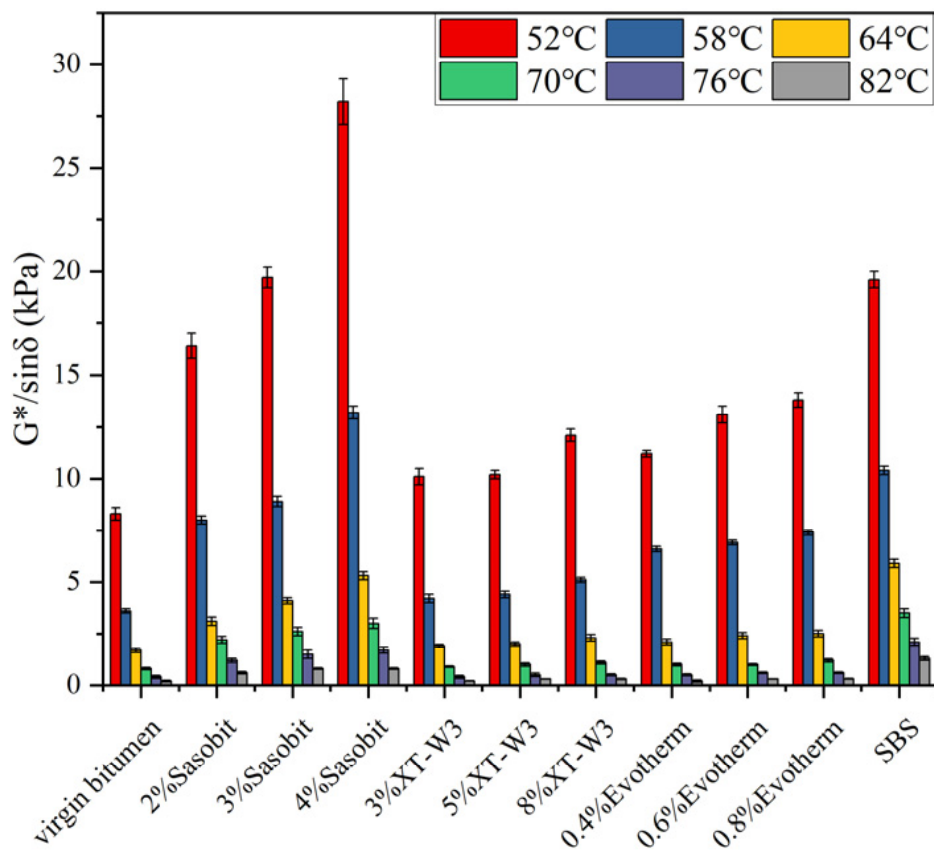
Figure 6. Results of the dynamic shear rheological test.